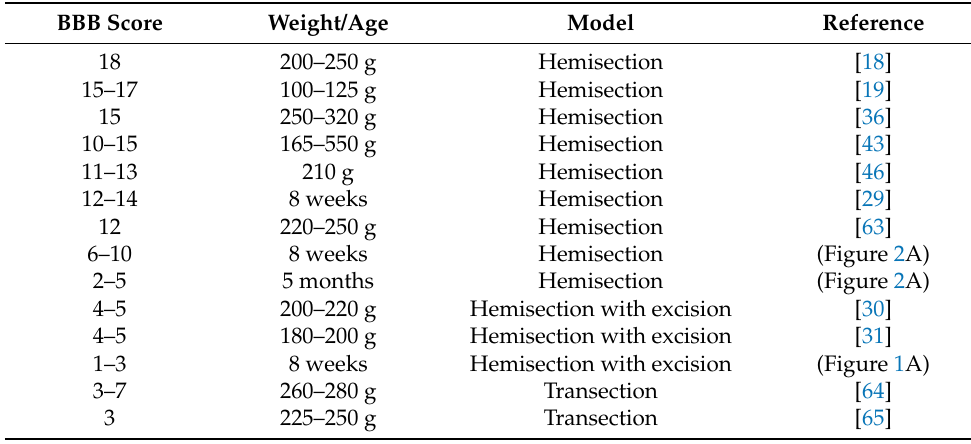
Table A3. The BBB rating scores in different SCI models across various